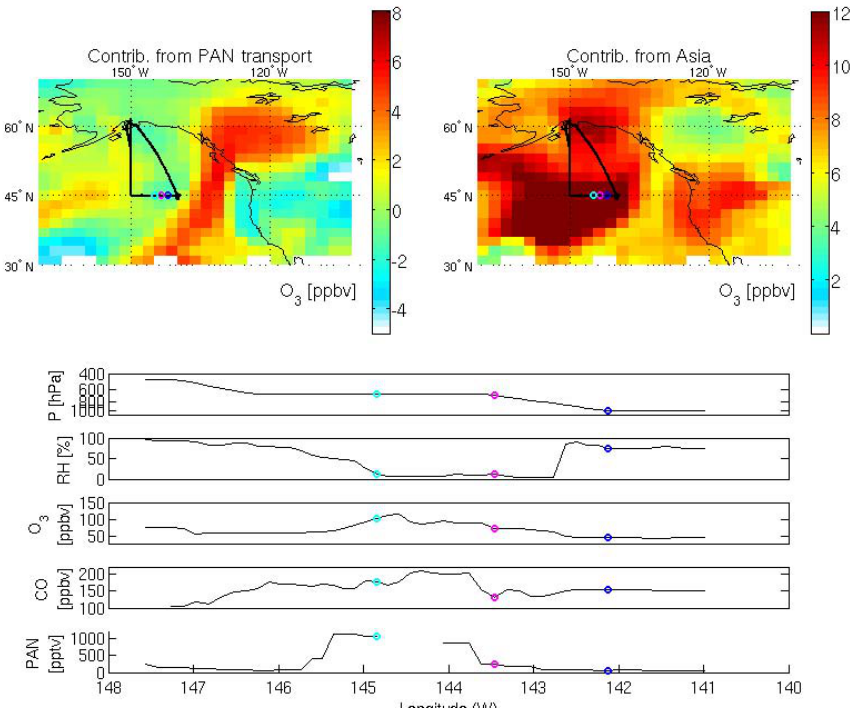
Fig. 14. Detail of the DC-8 measurements during the May 4, 2006 transport event. The top left panel shows the flight track of the DC-8 on May 4, 2006 overlaid on the simulated contribution to ozone concentrations due to transport of PANs at 4km. The top right panel displays the flight track atop the contribution from Asian emissions. The bottom plots show aircraft measurements during the westbound leg, where the aircraft encounters a plume of elevated O 3 , CO, and PANs at about 700hPa. Blue, magenta, and cyan circles mark the location of the aircraft on the maps during the data